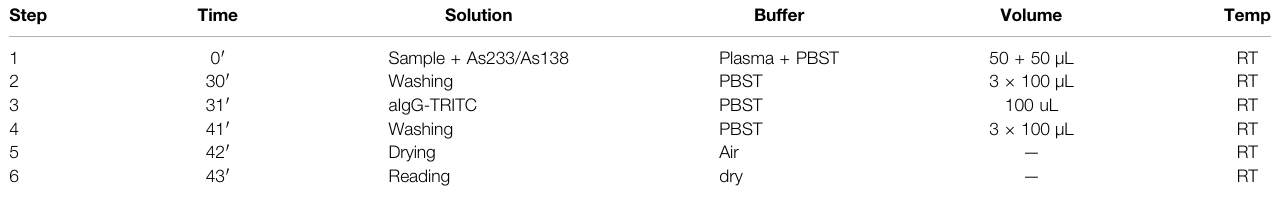
TABLE 2 | Assay protocol for the micro fl uidic device after holding the printed microarray slide. Step